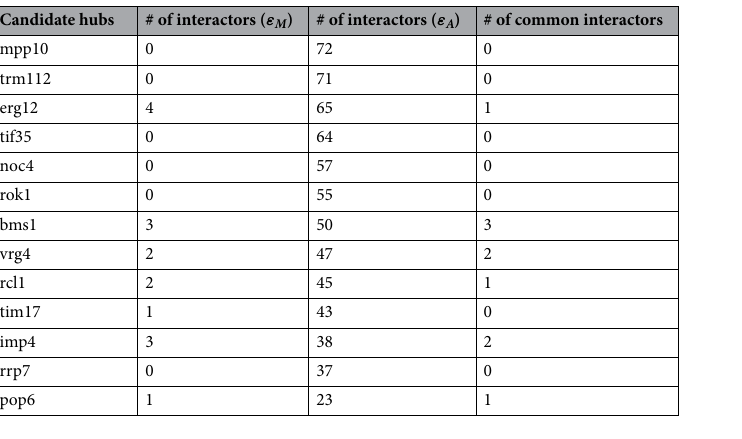
Table 2. List of genes that according to one measure has less than 10% of the number of interactions only captured by the other measure. The interactions scores were computed from the Essential x Essential library with the measures ε M = (cid:31) 11 − (cid:31) 01 (cid:31) 10 and ε A = (cid:31) 11 + 1 − (cid:31) 01 − (cid:31) 10